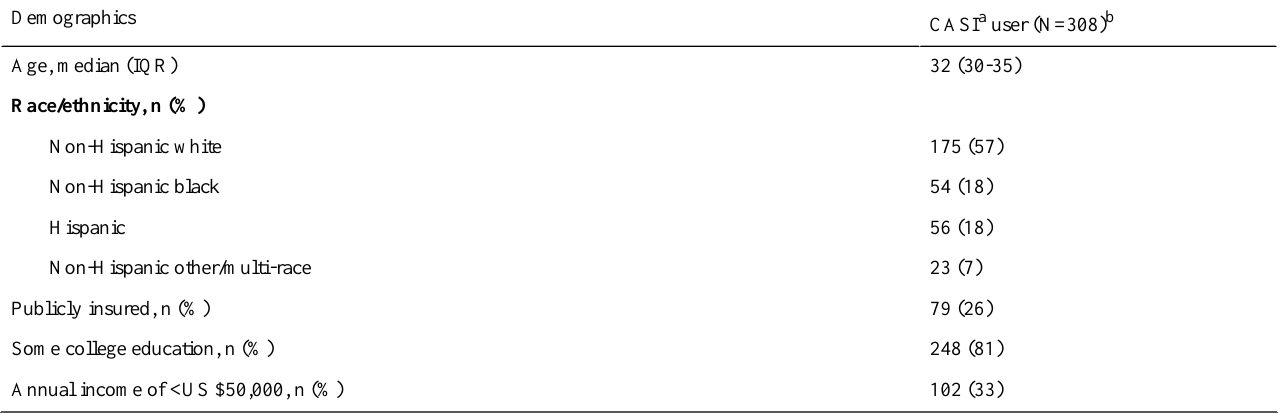
Table 2. Characteristics of the study sample.